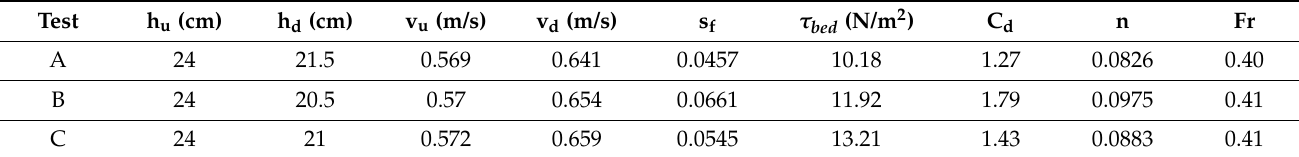
Table 1. Hydraulic parameters of the three